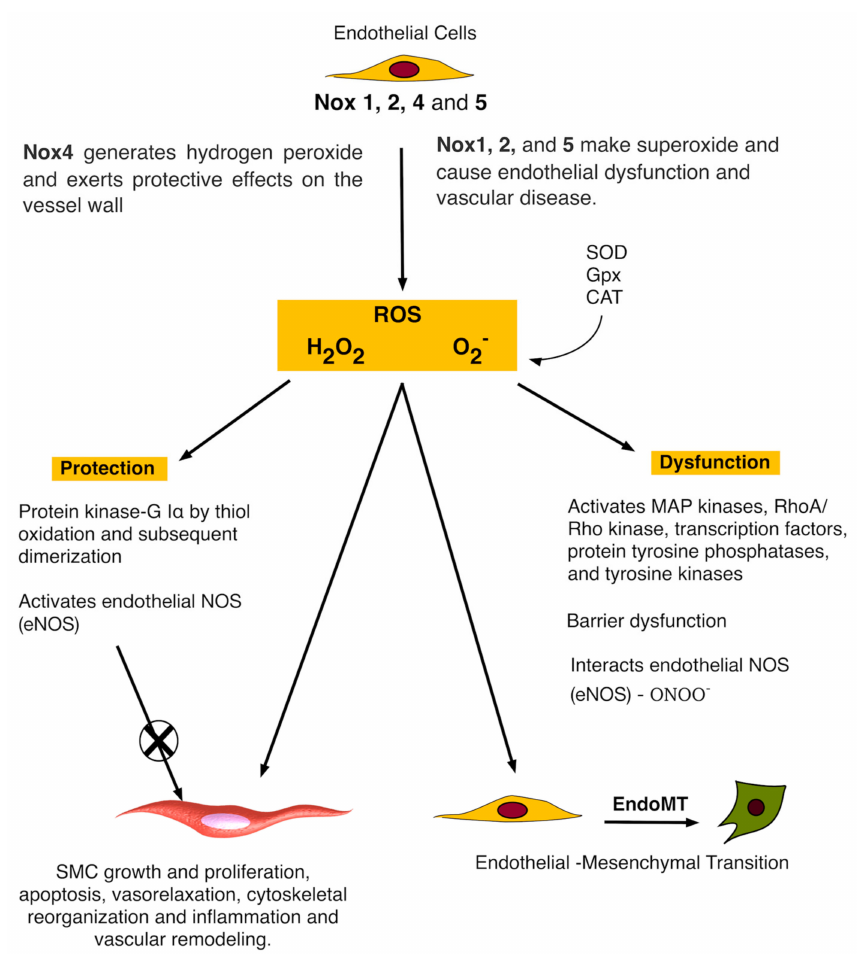
Figure 2. Simplified schematic of common forms of Nox enzymes in endothelial cells. H 2 O 2 can be converted to H 2 O by catalase (CAT) or glutathione peroxidase (GPx). O 2 − can also react with NO to generate the reactive nitrogen species ONOO − that could be converted into NO 2 · , which reacts with protein tyrosine residues to generate NO 2 -Tyr. This reaction can lead to a decrease in the bioavailability of NO, leading to endothelial dysfunction. Nox-derived ROS may also control endothelial-mesenchymal stem cell transition (EndoMT)